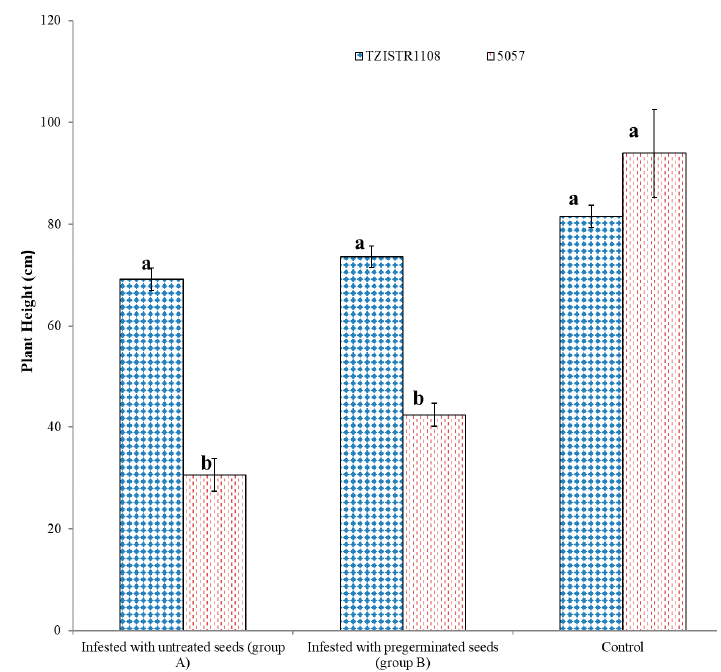
Figure 8. Mean plant height (cm) of infested (with seeds that were not pregerminated and with pregerminated seeds) and un ‐ infested maize plants of both lines grown on rhizotrons. The different letters (a and b) show significant differences among groups at α = 0.05. The bars show standard error.